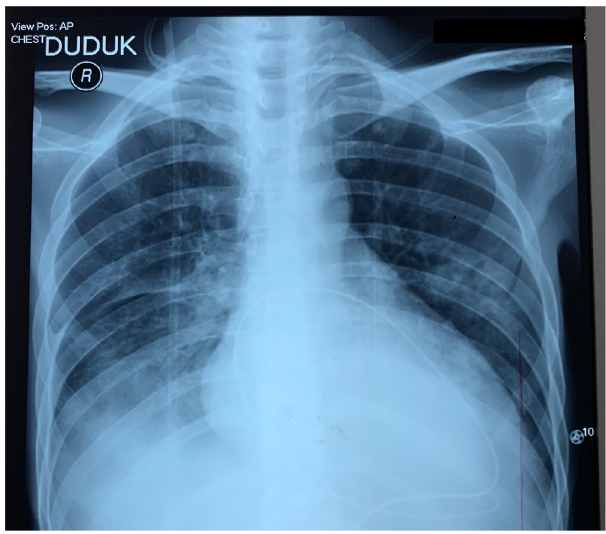
Figure 4. Chest X-ray on the 14 th day of treatment showed left parahilar ground glass appearance with suspicion of lung metastasis and pleural effusion. Pericardial fluid pigtail was already inserted for drainage of pericardial